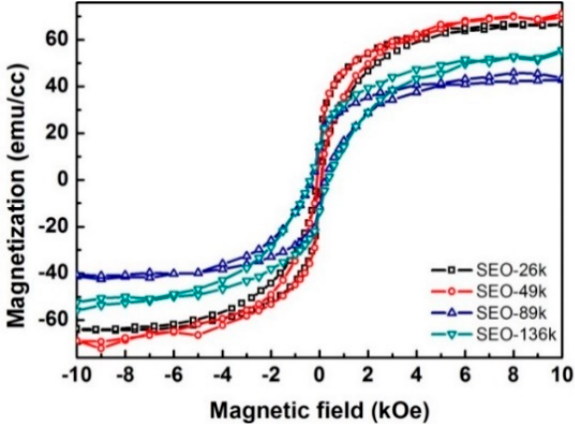
Figure 8. In-plane magnetization curves for nanodots prepared from four different block copolymer templates. All curves were measured at 300 K.